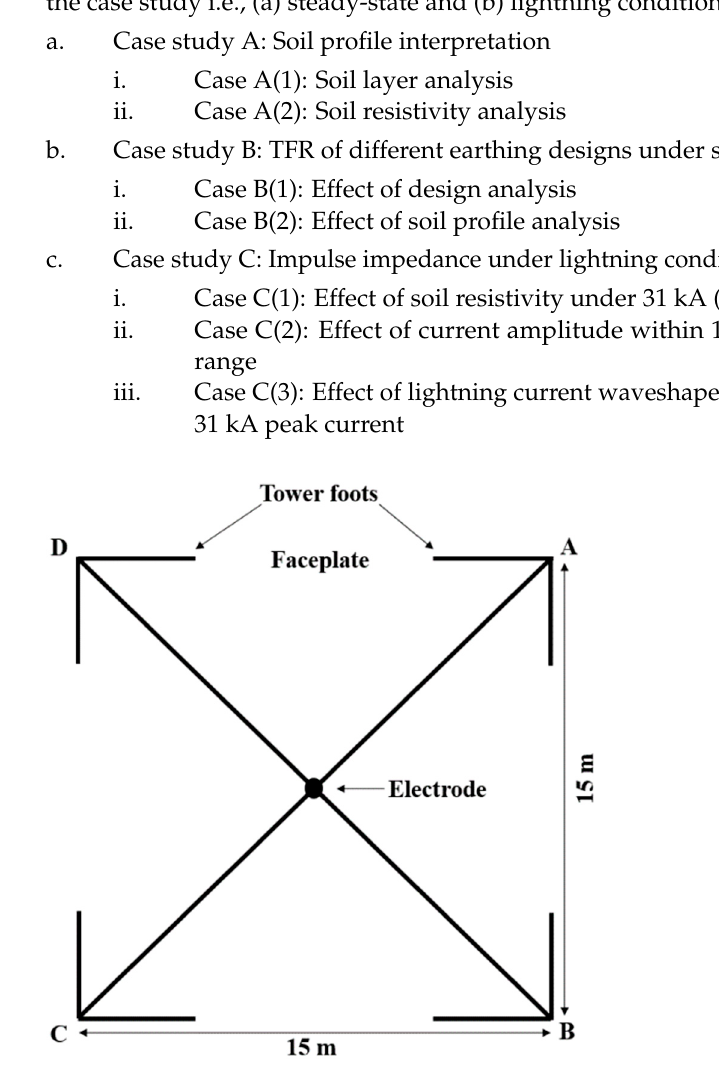
Figure 3. Default earthing design by the utility industry.